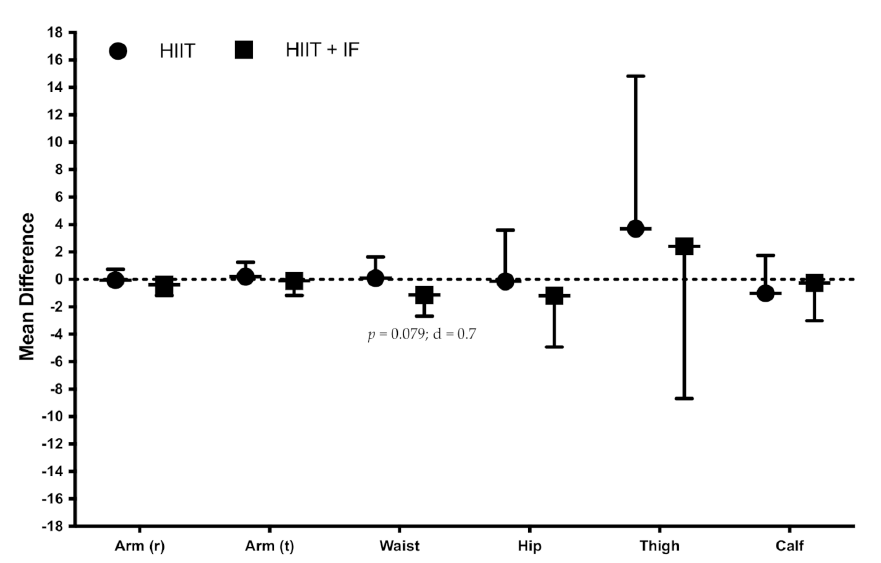
Figure 3. Effects of training on girths (cm; mean difference post-training vs. pre-training: mean ± standard deviation). r, relaxed; t, tensed; d, effect size.